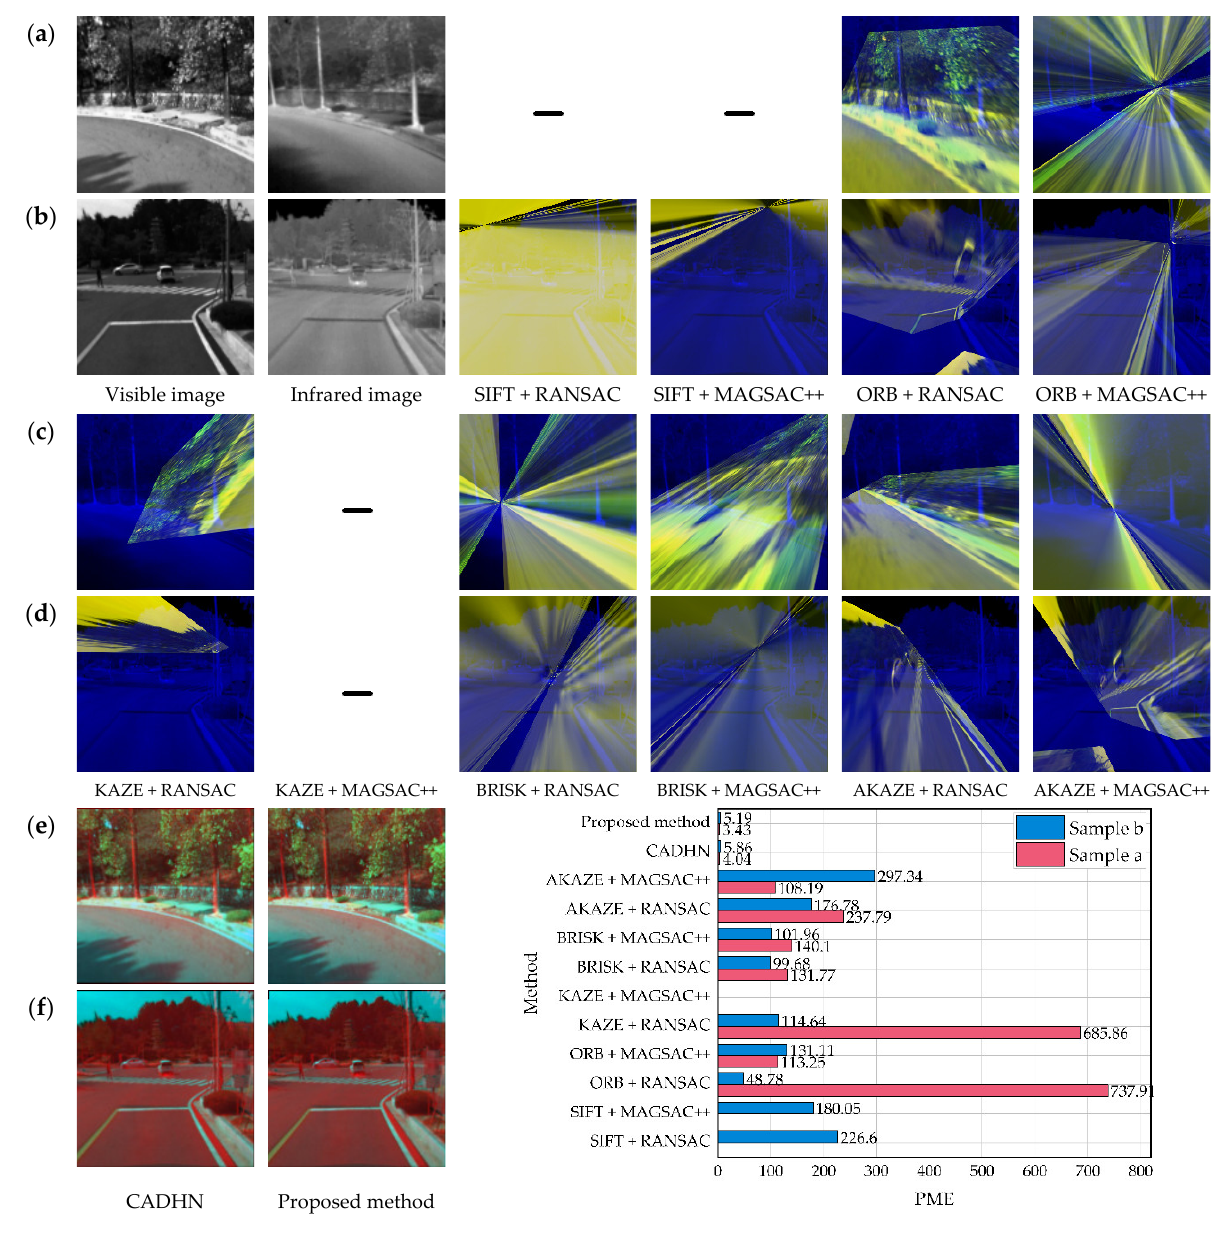
Figure 9. Qualitative comparison with 11 contrasting algorithms for two examples, including feature-based and deep learning-based solutions. ( a , c , e ) shows the results of the first example, and ( b , d , f ) shows the results of the second example. We also show the PME [40] of different contrast algorithms in two examples.